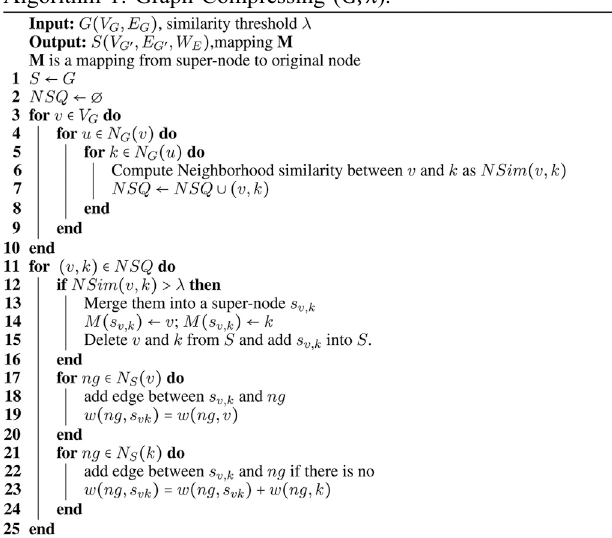
Algorithm 1: Graph Compressing ( G , λ